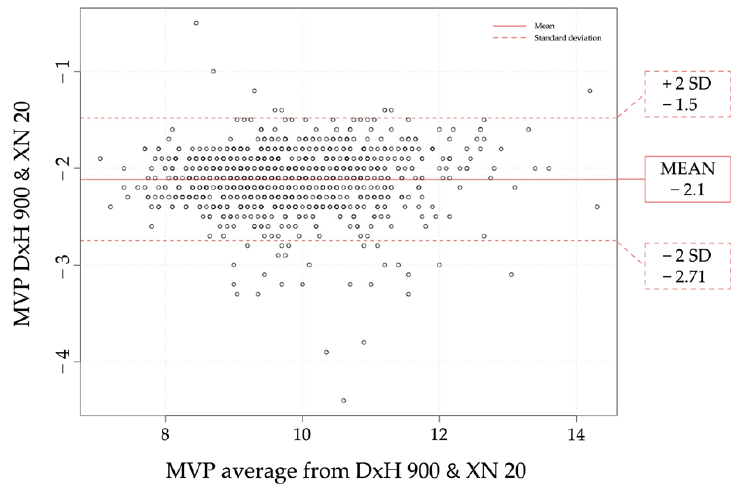
Figure 2. Bland Altman plot comparing MVP in both analyzers. Results from the two analyzers plotted against the median of the two techniques. Solid point line is related to the mean of the results; hollow point line is related to positive and negative standard deviation.